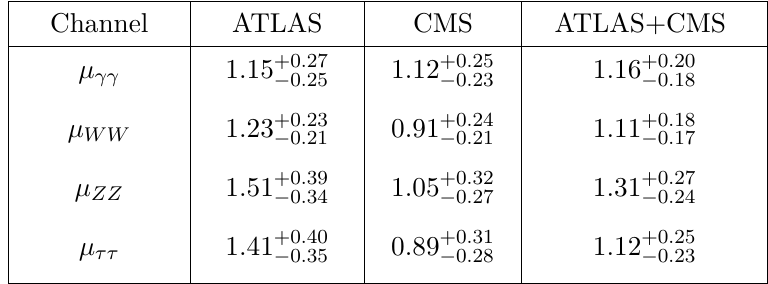
Table 1 . Combined ATLAS and CMS results for the 8 TeV data, ref.